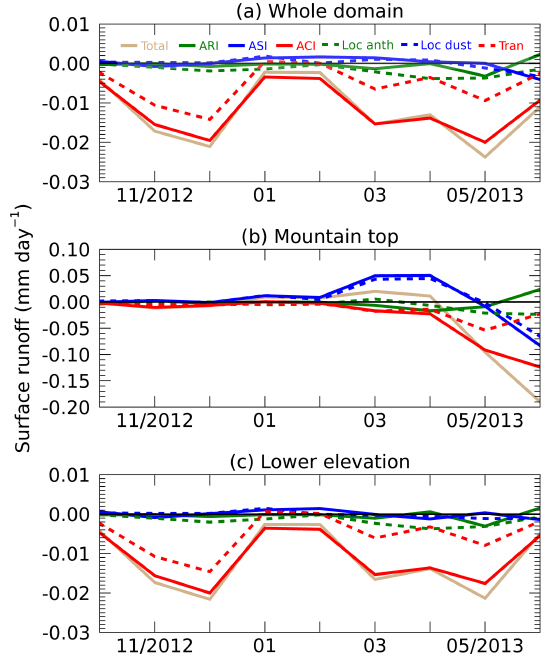
Figure 17. Same as Fig. 14, but for surface runoff (mmday − 1 )